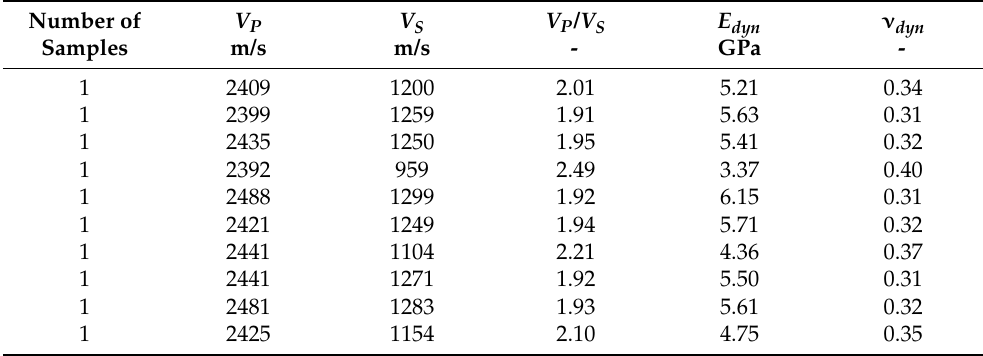
Figure 4. Example stress and strain curves of selected hard coal laboratory specimens of the USCB carboniferous formation: ( A ) Mudstone Series; ( B ) Upper Silesian Sandstone Series. Table 4. Results of ultrasonic tests of the coal